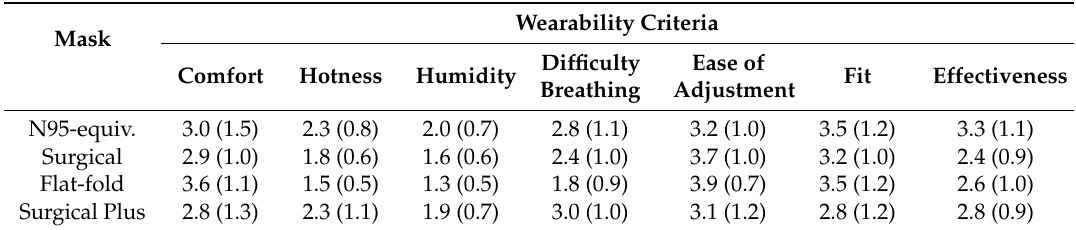
Table 3. The percentage (%) of participants ranking each mask first for each wearability criterion + . Wearability Criteria Mask Ease of Comfort *** Fit *** Effectiveness *** Overall ** Breathing *** N95-equiv. 30.0 Surgical Flat-fold Surgical